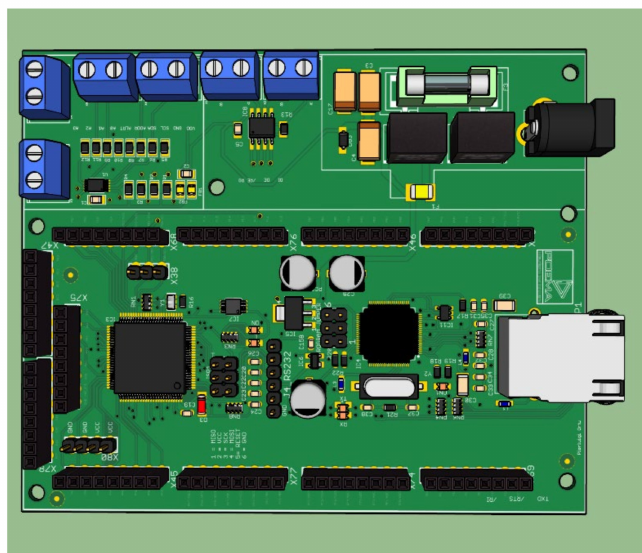
Figure 11. Design of the new integrated, compact and robust board. It is composed by only